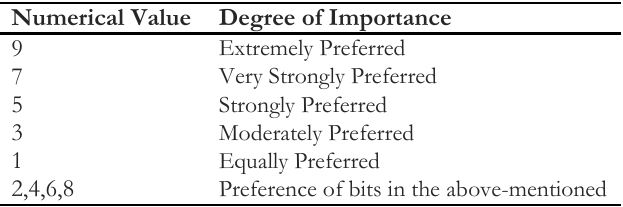
Table 2. Preference values for paired comparisons.